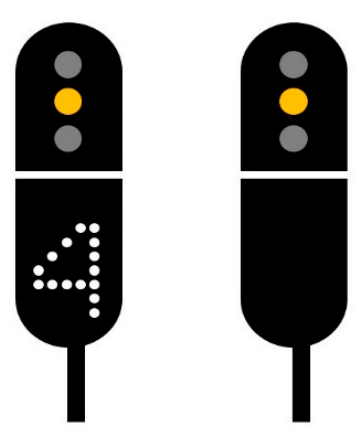
Figure 8. Signals with “yellow:number” and “yellow” aspects are visually similar.